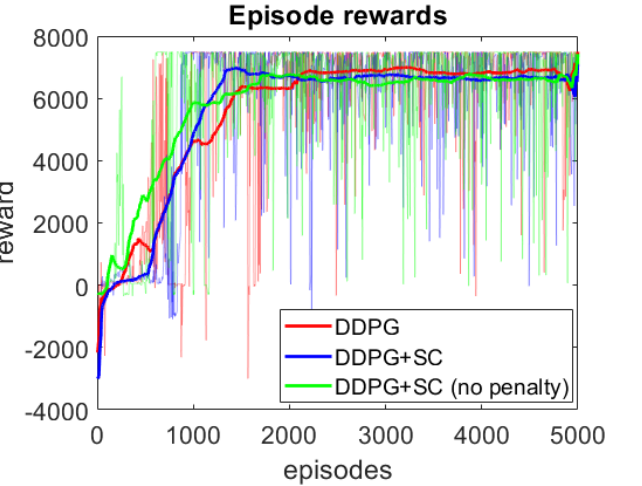
Figure 4. Episode rewards during DDPG training. Darker lines represent the moving average reward plot, whilst the actual reward values are seen in the transparent